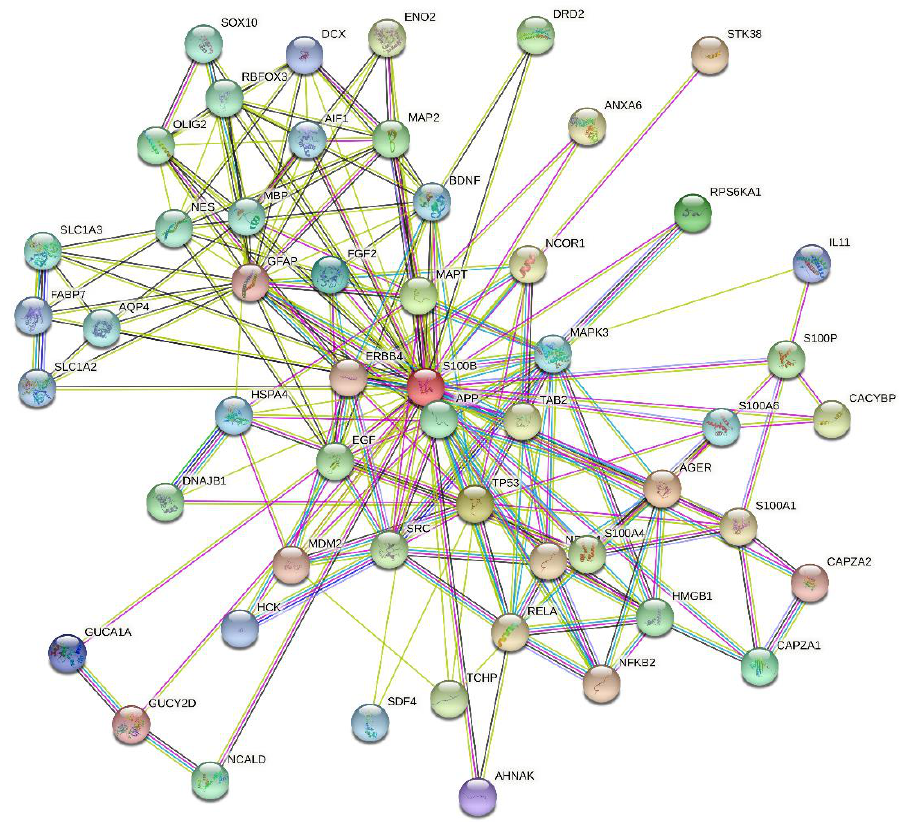
Figure 1. S100B-centered protein–protein interaction (PPI) network generated by STRING using high confidence level of 0.7 [47]. In this network, the nodes correspond to proteins, whereas the edges show predicted or known functional associations. Seven types of evidence are used to build the corresponding network, and are indicated by the differently colored lines: a green line represents neighborhood evidence; a red line—the presence of fusion evidence; a purple line—experimental evidence; a blue line—co-occurrence evidence; a light blue line—database evidence; a yellow line—text mining evidence; and a black line—co-expression evidence [47]. This network includes 53 proteins connected by 205 interactions. As a result, an average node degree of this network is 7.74.